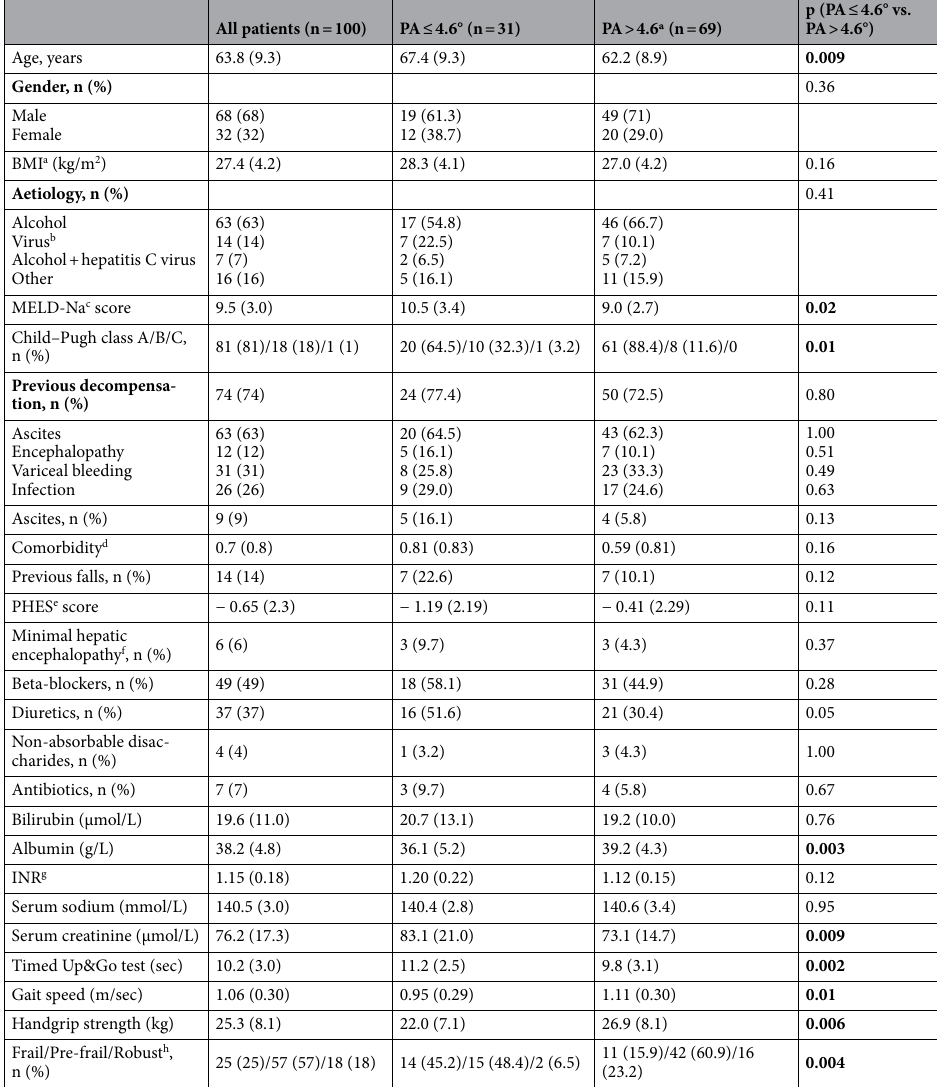
Table 1. Characteristics of patients: all patients, patients with phase angle (PA) ≤ 4.6° and patients with PA > 4.6°. Data are expressed as frequencies and percentages or mean (SD). P values in bold indicate statistical significance (p < 0.05). a BMI: body mass index. b Hepatitis C virus: PA ≤ 4.6° five, PA > 4.6° four; Hepatitis B virus: PA ≤ 4.6° two, PA > 4.6° three. c MELD-Na: Model for end-stage liver disease-sodium. d Excluding cirrhosis from Charlson score. e PHES: Psychometric hepatic encephalopathy score. f PHES < -4. g International normalized ratio. h According to Fried frailty criteria: frail 3 criteria, pre-frail 1–2 criteria, robust 0